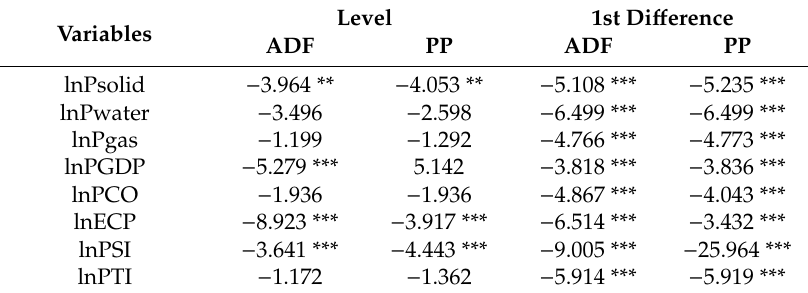
Table 6. The results of unit root tests.